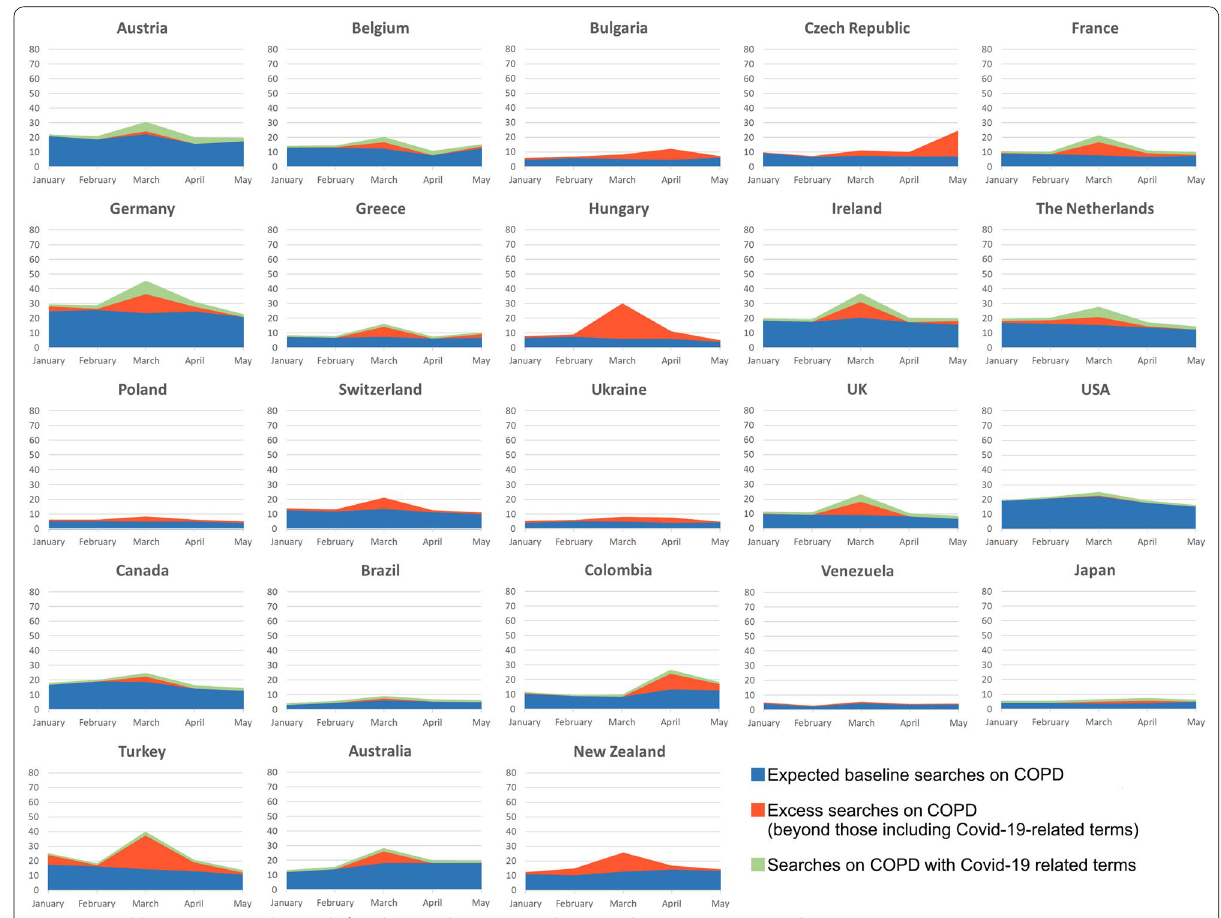
Fig. 3 Monthly average Google Trends for “chronic obstructive pulmonary disease” (COPD) (as a disease) (2020,